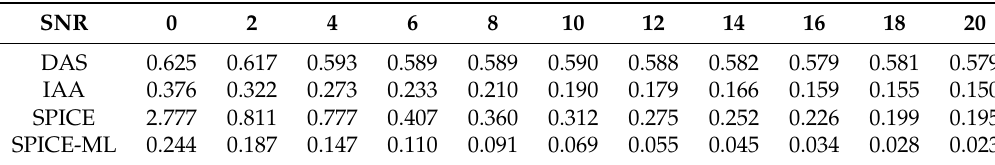
Table 4. RMSE vs. SNR with coherent signal.